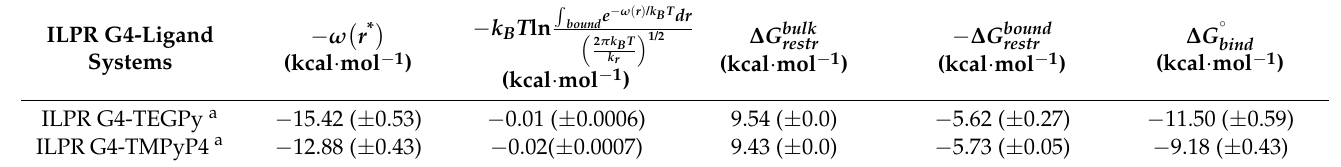
Table 1. Absolute binding free energy in the ILPR G4- TMPyP4 and ILPR G4-TEGPy